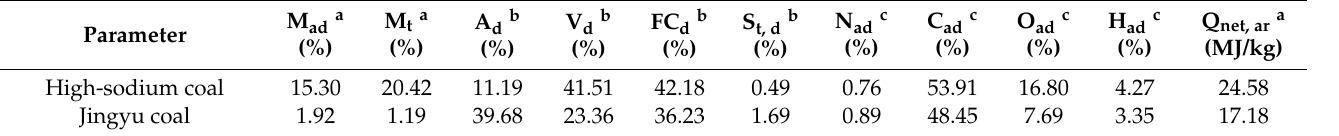
Table 1. Fuel quality information.